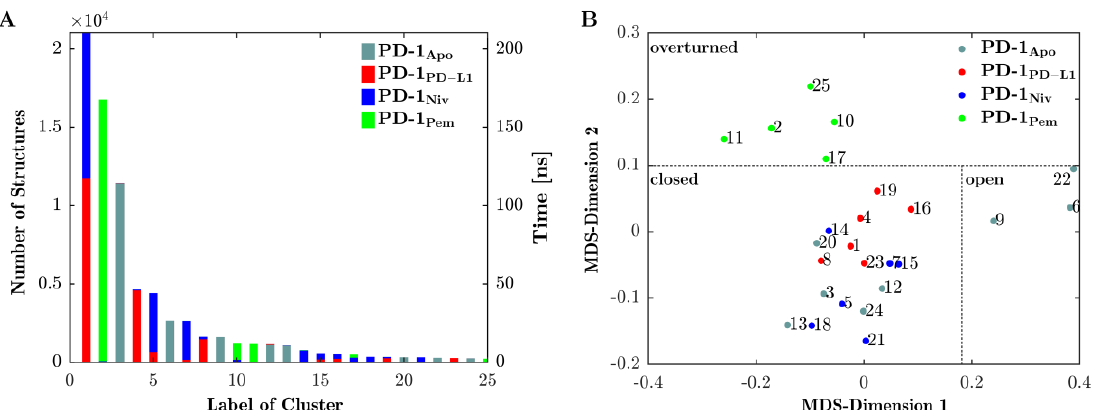
Figure 4. The CC‘-loop exhibits three conformations. ( A ) CC’-loop structures along the 4 joined trajectories (see legend) are clustered (clusters labelled 1–25) and the number of structures belonging to each cluster are displayed on the left vertical axis. The number of clusters is equivalent to the time during which the CC’-loop assumes a configuration within the respective cluster (right vertical axis, time [ns]). Similar structures may originate from one or from more trajectories, hence bars maybe uniquely colored or stacked in color, respectively. For example, the conformation seen in cluster 2 appears only in trajectory PD-1 Pem (green) whereas cluster 1 appears in both PD-1 PD-L1 (red) and PD-1 Niv (green). ( B ) The central structures of each cluster were projected into 2-dimensions (MDS-dimensions 1 and 2) by multidimensional scaling (MDS). Central structures are colored according to the trajectory from which they originate, similar to panel ( A ). MDS groups central structures of the clusters according to mutual similarity, allowing for an interpretation of similarity between clusters. Resulting groups can be identified to represent certain types of conformations: ‘open’, ‘closed’ or ‘overturned’, see Figures 5 and 6 for 3D visualizations. Note that the labels ‘open’, ‘closed’, and ‘overturned’ do not directly emerge from meta-clustering but are coined after visual interpretation of central frames, as shown in Figure 5. Nevertheless, for clarity we already use them in this figure. Dotted lines between clusters – delineating the meta-clusters—are drawn by hand.